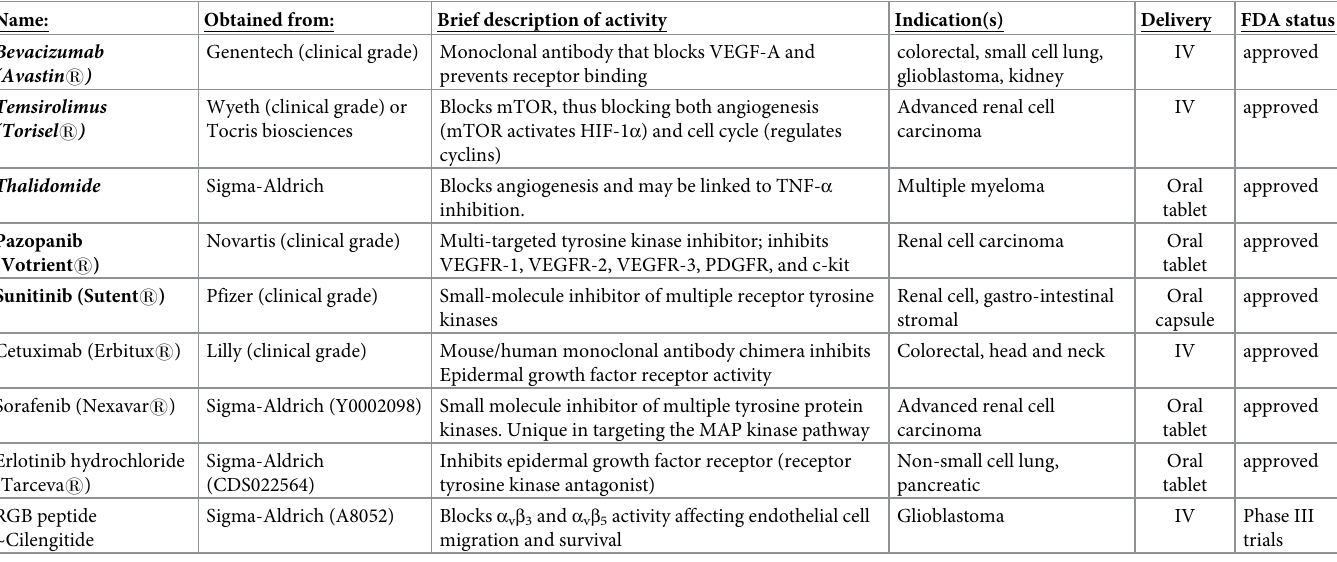
Table 1. List of angiostatics obtained and tested in our CAM model for screening for synergistic